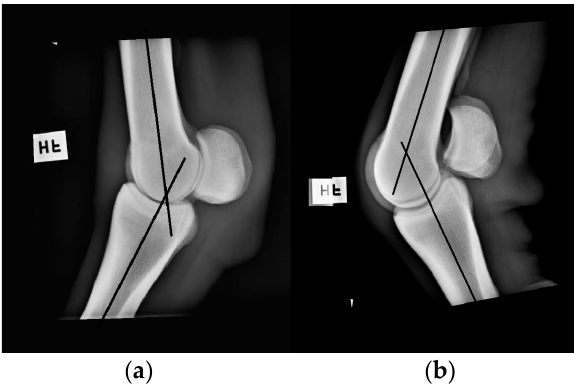
Figure 3. Radiographic images of the fetlock joint in a ( a ) neutral position and in ( b ) flexion (photo: Nicole Gandre Lauridsen).